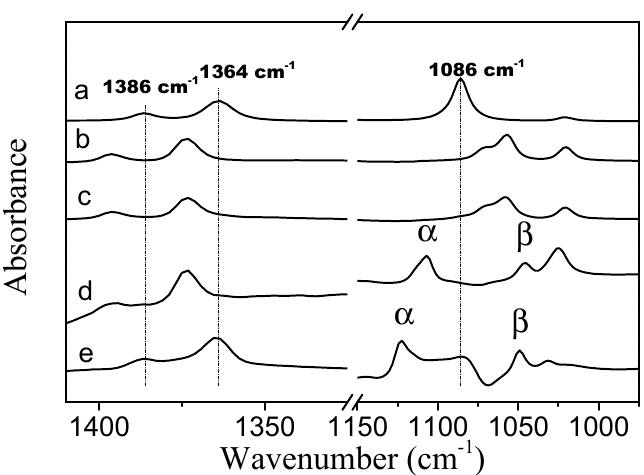
Figure 8. Corrected ATR FTIR spectra of ( a ) TBME at a temperature of 301 K; ( b ) TBME in D 2 O at a concentration of 5 wt % and a temperature of 278 K; ( c ) TBME in D 2 O at a concentration of 5 wt % and a temperature of 301 K; ( d ) PVME/TBME/D 2 O at c P = 10 wt % and c ad = 5 wt % and a temperature of 278 K; and ( e ) PVME/TBME/D 2 O at c P = 10 wt % and c ad = 5 wt % and a temperature of 301 K.